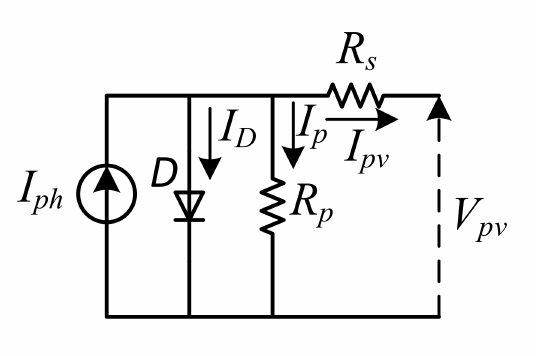
Figure 2. PV array equivalent